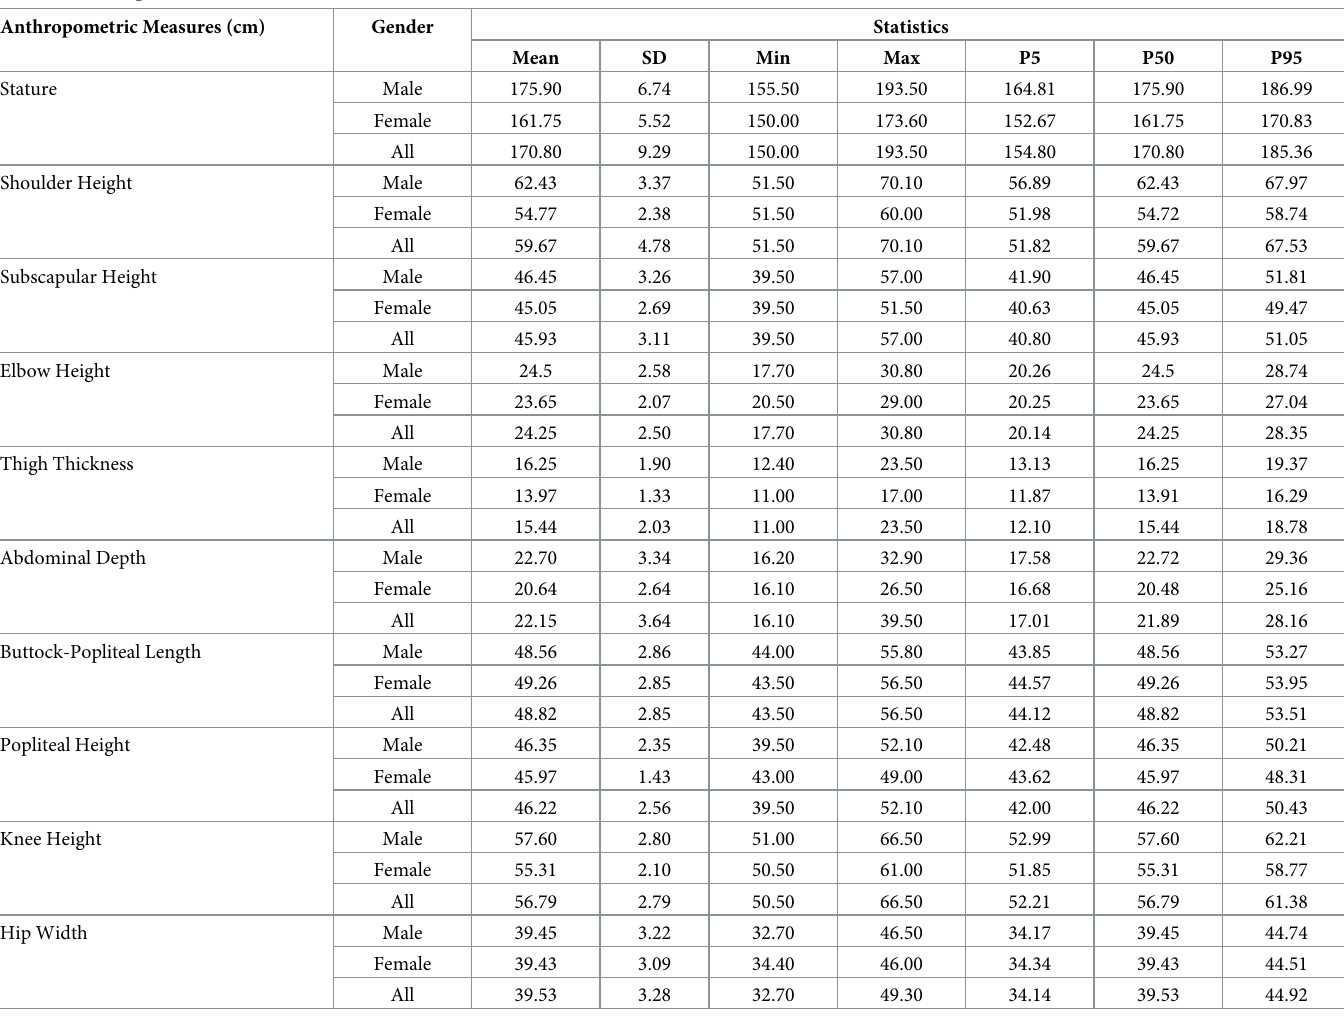
Table 4. Anthropometric